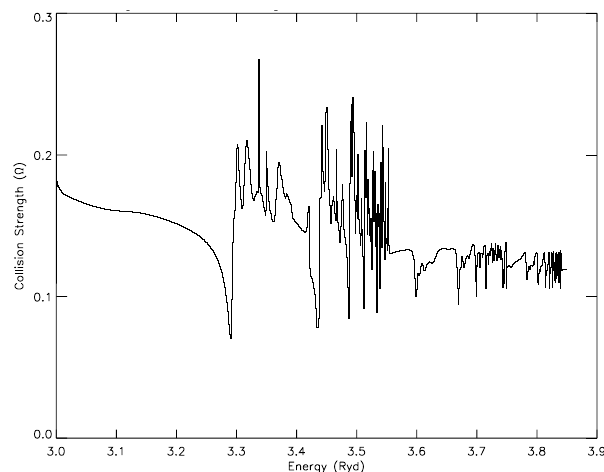
Figure 6. Collision strengths for the 1s 2 S 1/2 –2s 2 S 1/2 (1–2) transition of He II.